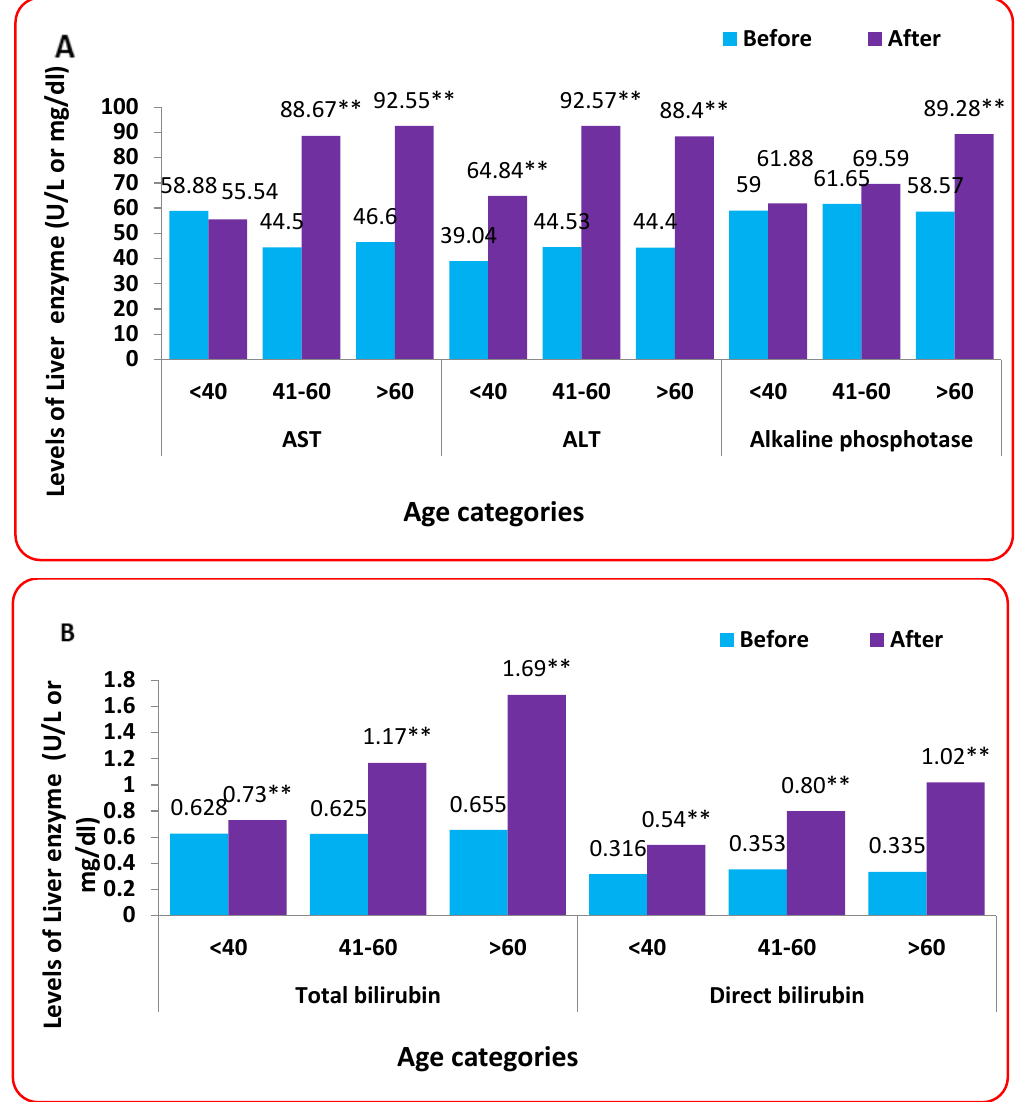
Figure 6. Effect of age categories on liver function ( A , B ). ** means significant difference using paired t -test at p < 0.05.